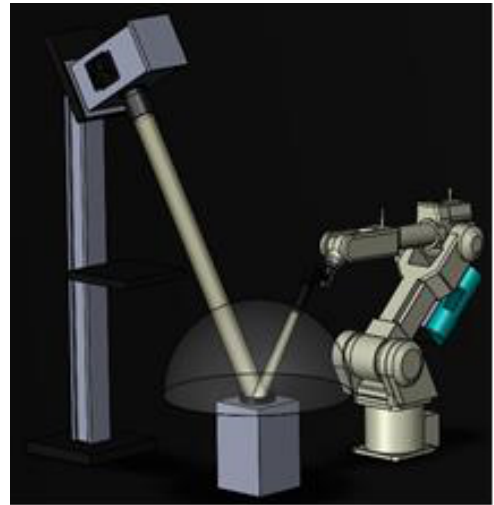
Figure 2. The Laboratory Goniometer System